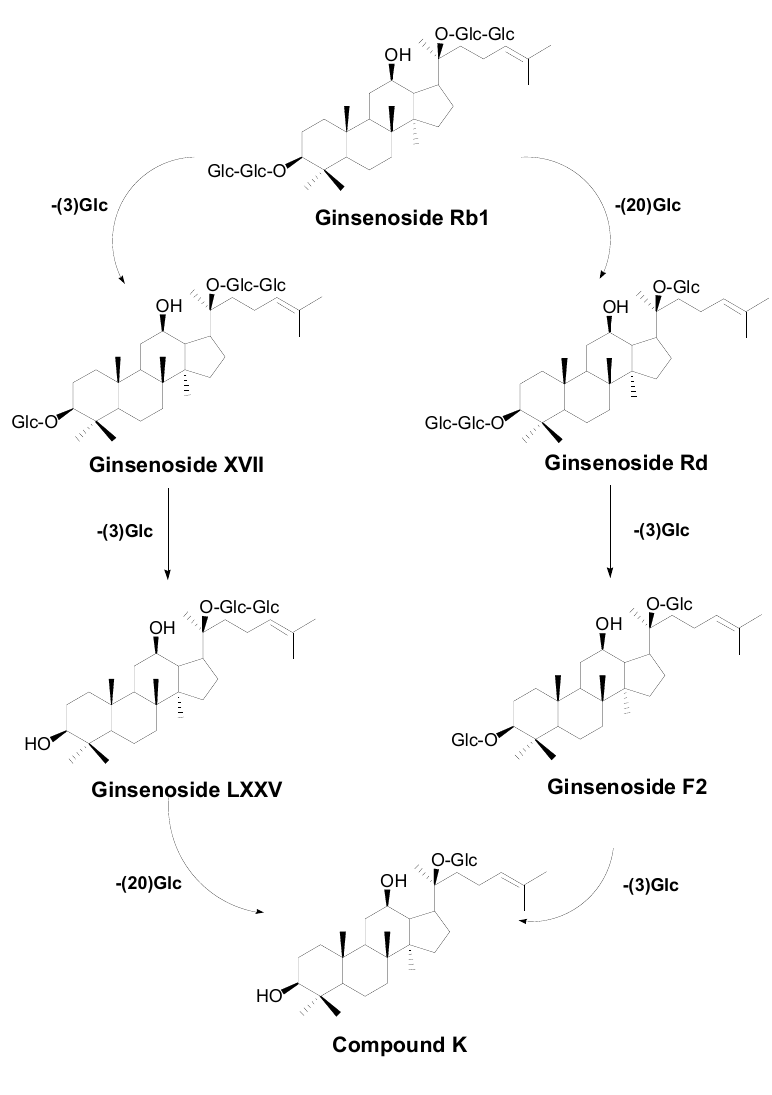
Figure 7. Theoretical biotransformation pathways for ginsenoside Rb1 →